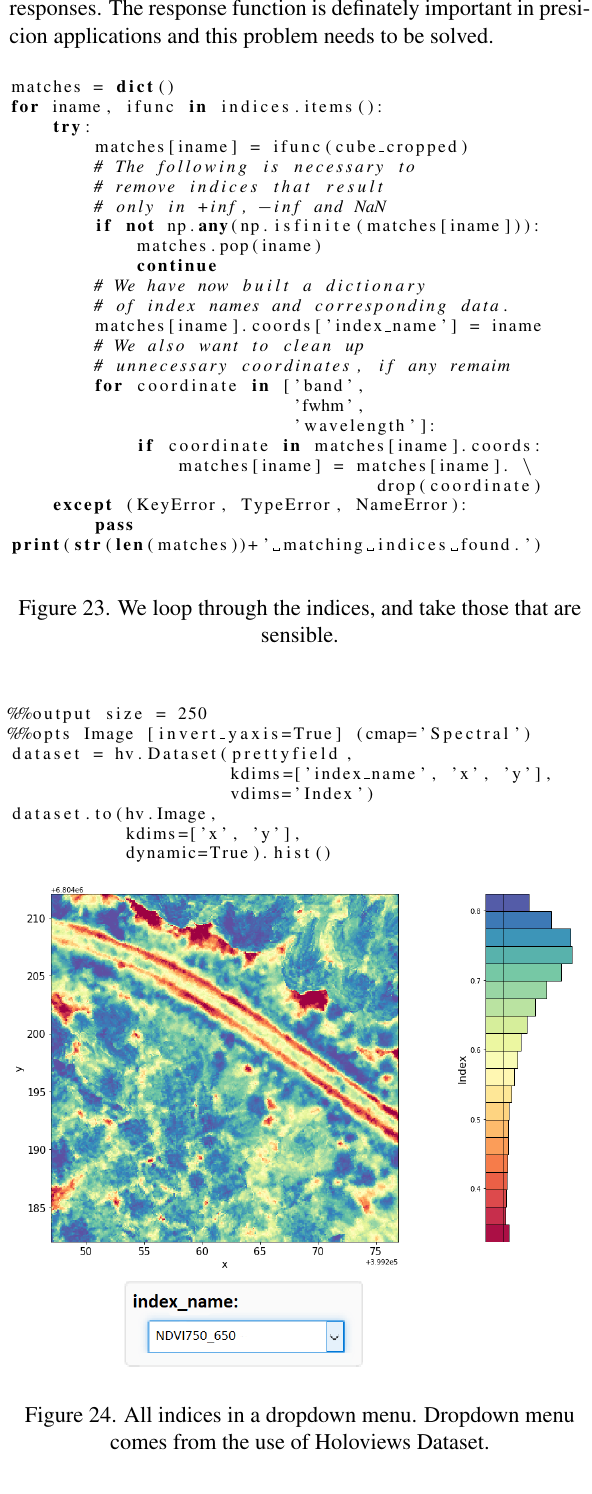
Figure 22. The initialisation process of spectral indices library. This is still work in progress.